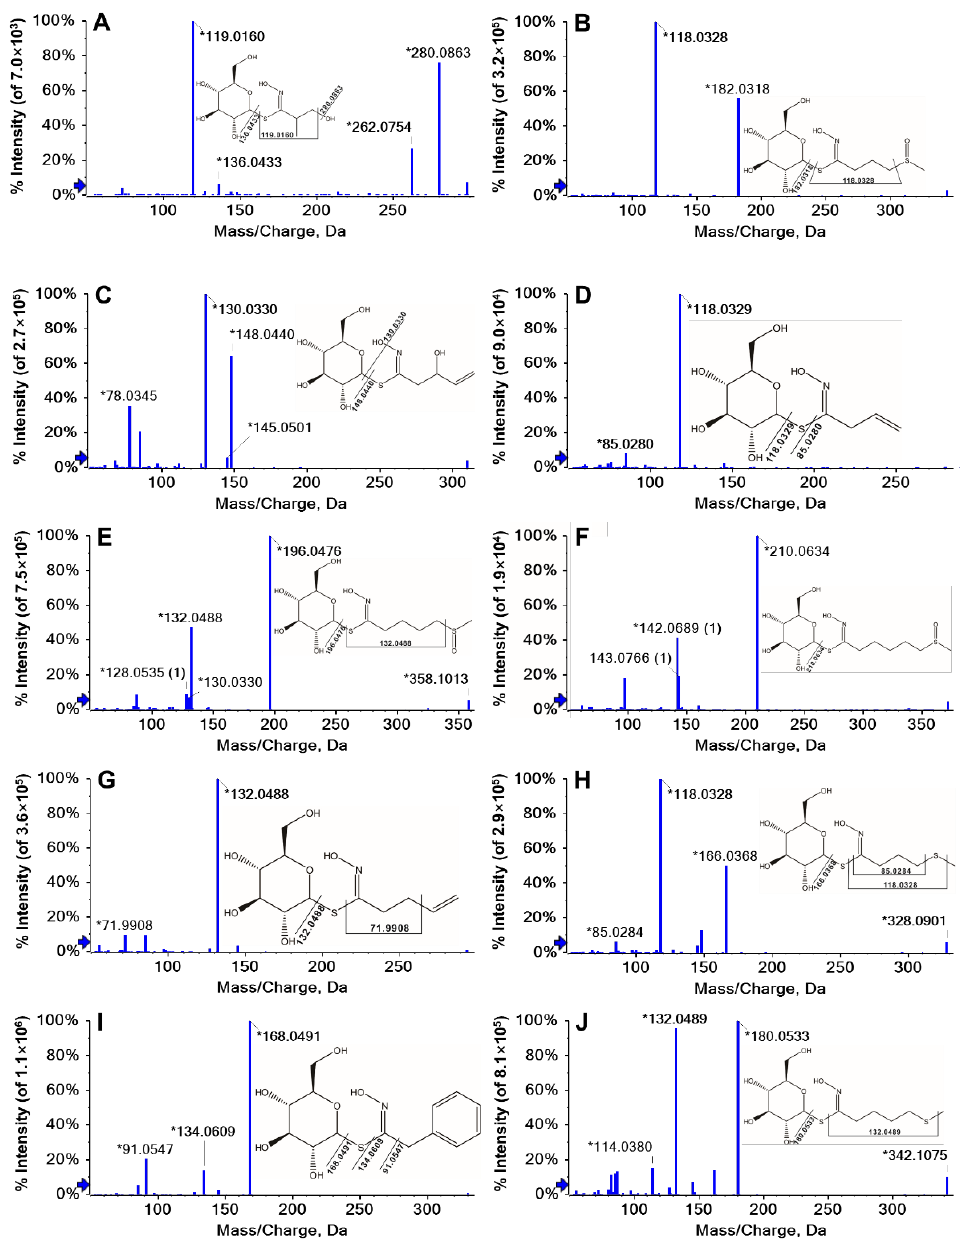
Figure 1. LC–MS/MS spectra of aliphatic glucosinolates and their chemical structures in broccoli. GTP is the internal standard which is an aromatic GL. ( A ), Glucosisymbrin (GSI); ( B ), Glucoiberin (GIB); ( C ), Progoitrin (PRO); ( D ), Sinigrin (SIN); ( E ), Glucoraphanin (GRA); ( F ), Glucoalyssin (GAL); ( G ), Gluconapin (NAP); ( H ), Glucoibervirin (GIV); ( I ), Glucotropaeolin (GTP); ( J ), Glucoerucin (GER). The * sign indicates that this fragment ion is generated by this molecular ion peak, which is judged by the liquid mass